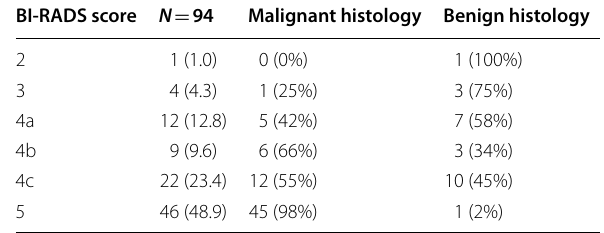
Table 4 BI-RADS